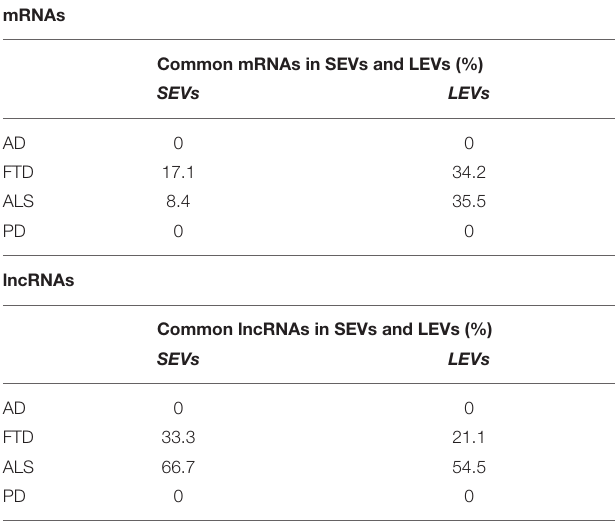
TABLE 3 | Percentage of common mRNAs and long non-coding RNAs (lncRNAs) in SEVs and LEVs in AD, FTD, ALS, and PD.